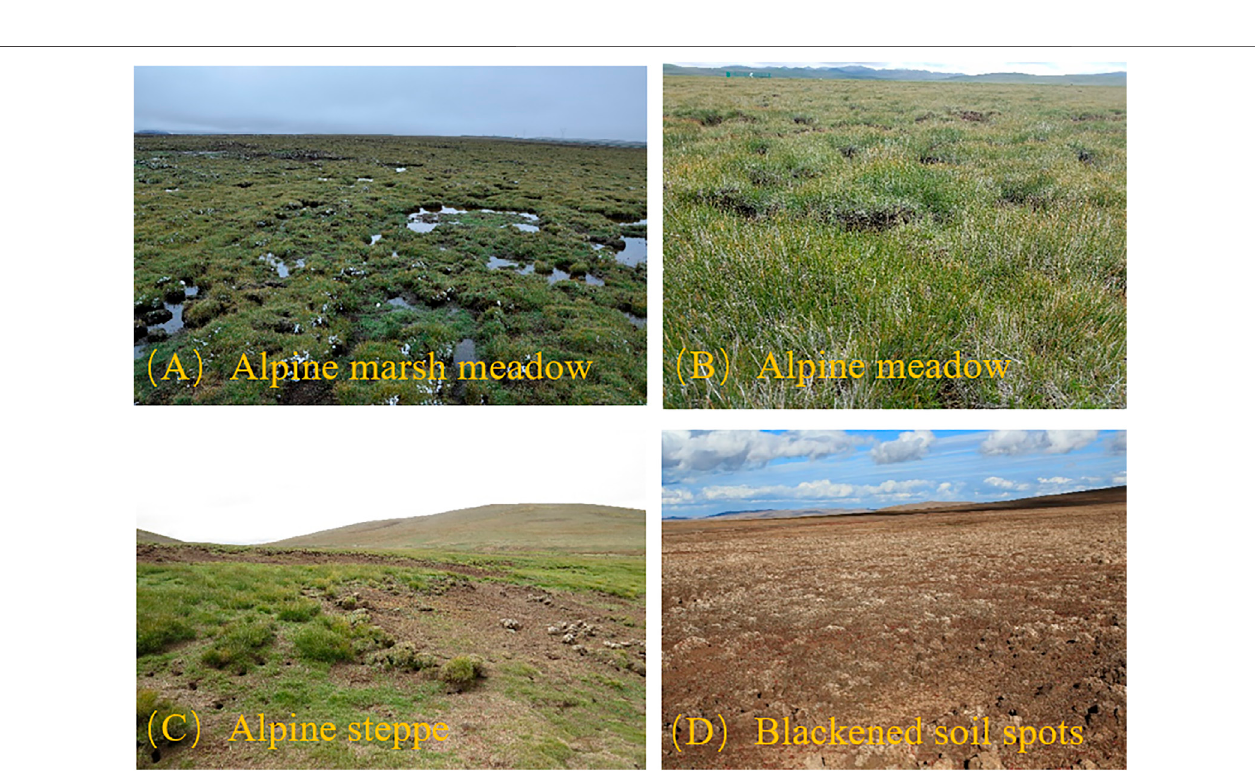
FIGURE3| Degradationofalpinemeadows intoblackened soilspotsintheHeadwater AreaofYellowRiveronthenortheasternQinghai-TibetPlateau,Southwest China. (A) Alpinemarshmeadowwithhighsedgecoverandsaturatedsoil, (B) alpinemeadowwithhighsedgecoverbutlesssoilwatercontent, (C) Alpinesteppewitha lower sedge cover and weeds, and (D) blackened soil spots without sedge and with dry soil.